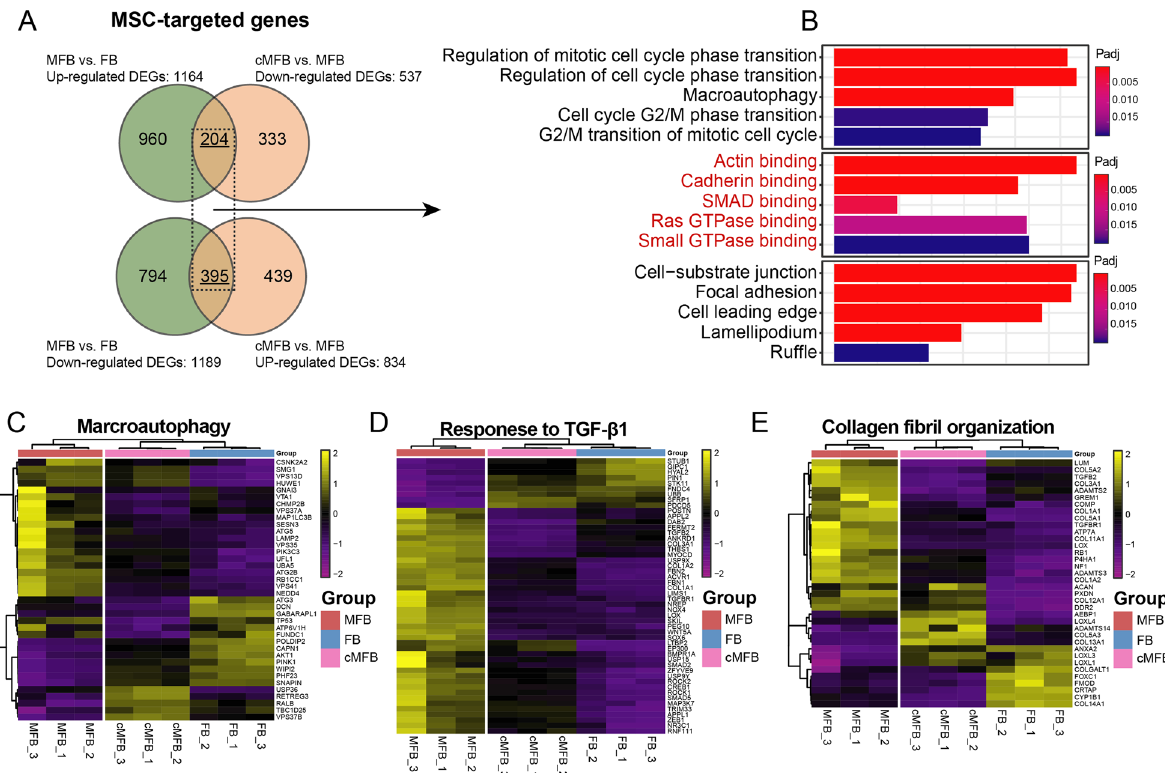
Fig. 6 Annotation of the targeted genes during uMSC-mediated MFB de-differentiation. A Venn diagrams depicting the number of DEGs regulated in MFB (MFB vs. FB) and then reversely regulated in co-cultured MFB (co-cultured MFB vs. MFB). B Enriched gene ontology analysis (EGO) concerning biological process (BP), molecular function (MF), and cellular component (CC) using the targeted DEGs. C – E Unsupervised clustering heatmap on genes participating in macroautophagy, response to TGF-β1, and collagen fibril organization in FB, MFB, and co-cultured MFB